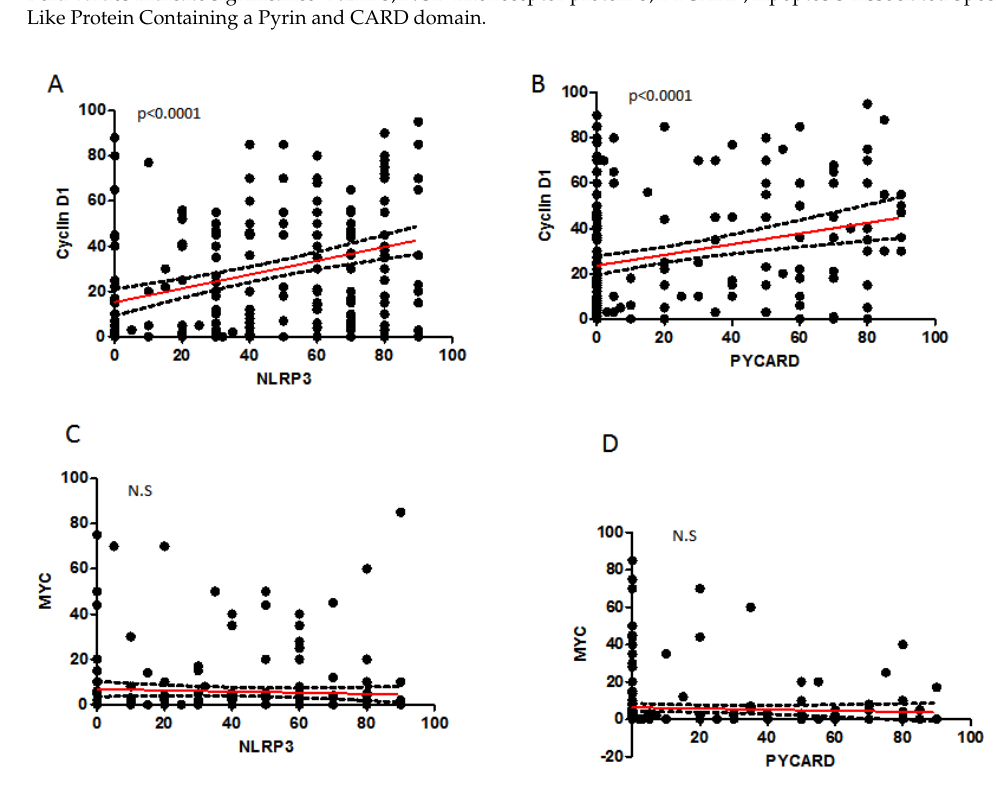
Figure 3. Spearman correlation (SC) between proteins. ( A ) SC between NLRP3 and CyclinD1. ( B ) SC between PYCARD and CyclinD1. ( C ) SC between NLRP3 and MYC. ( D ) SC between PYCARD and MYC. NS: not significant.